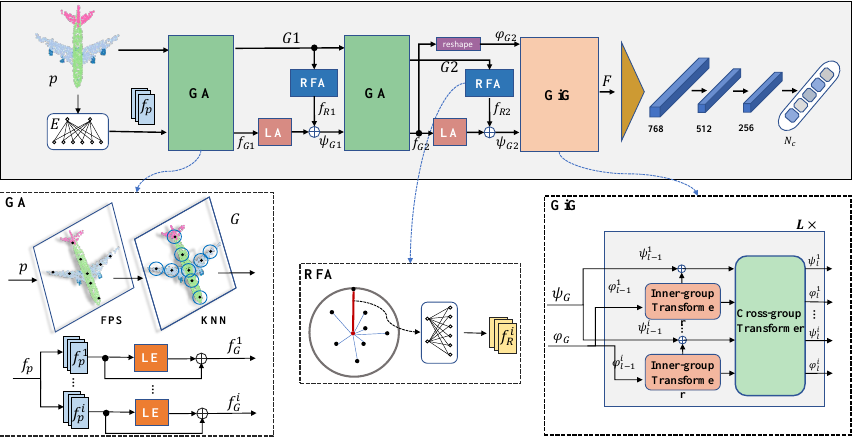
Figure 1. Group-in-group relation-based transformer network for point cloud